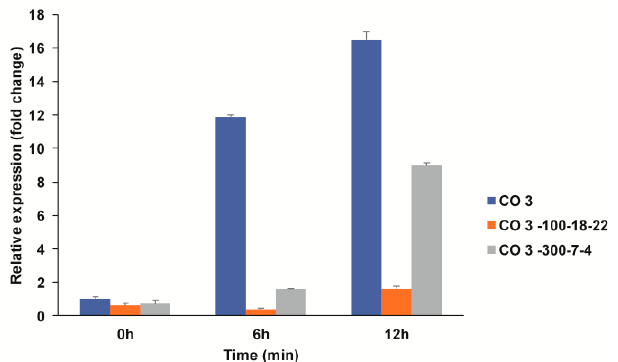
Figure 12. Relative expression profile of Rht-B gene analyzed using qRT-PCR under dehydration stress for 0 h (control), 6 h (early) and 2 h (late) in 21-day-old seedlings of CO 3, CO 3-100-18-22, and CO 3-300-7-4.